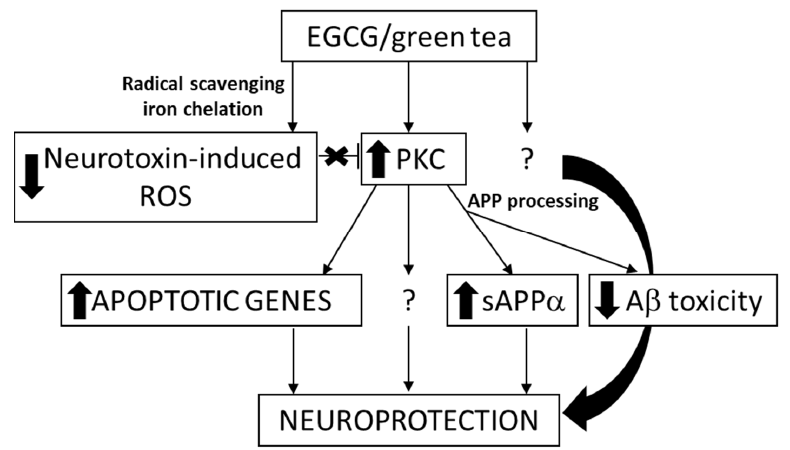
Figure 2. The suggested targets involved in the neuroprotective actions of EGCG [68].